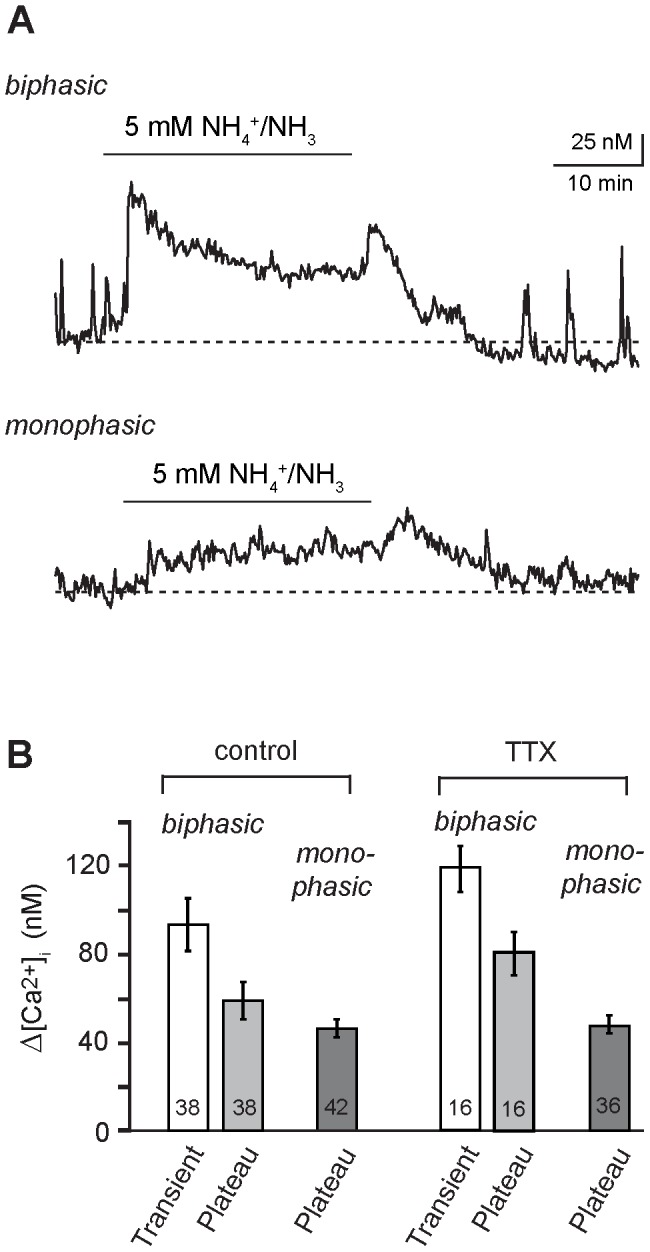
NH4
+-induced changes in intracellular calcium in hippocampal astrocytes.
(A) Calcium changes evoked by bath perfusion with 5 mM NH4
+/NH3 for 30 minutes (indicated by bar) in two different SR101-positive astrocytes of the hippocampus. Upper trace: biphasic response consisting of a transient elevation followed by a plateau phase. Lower trace: monophasic response with a plateau phase only. Note the additional transient increase in calcium upon washout of NH4
+/NH3 in both cells. (B) Histogram showing the mean peak amplitude ± S. E. M. of NH4
+/NH3-induced transient and persistent (“plateau”) calcium changes in biphasic and monophasic cells in the absence (“control”) and presence of 0.5 µM tetrodotoxin (“TTX”). The number of cells is given within the bars. Response amplitudes in TTX are not different to those in the control.